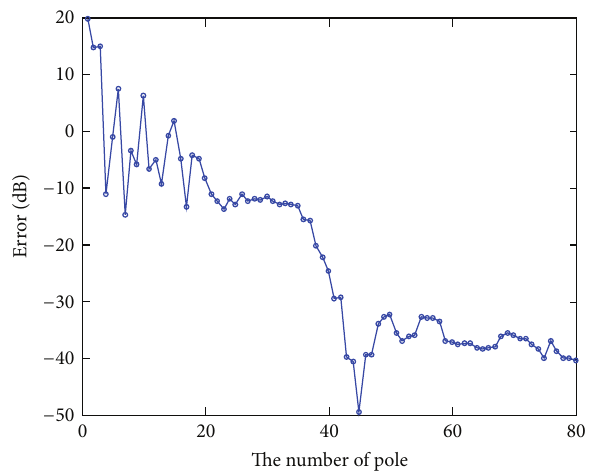
Figure 1: The error is changing with the value of 𝑀 in different.